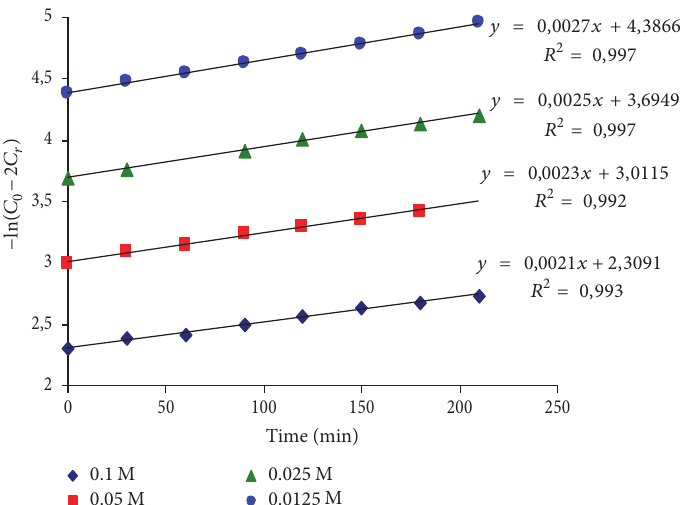
Figure 6: Evolution of the term − ln (𝐶 0 − 2𝐶 𝑟 ) versus time for facilitated extraction of VO 2+ ions by SLM containing extractive agent RESO. [H 3 O + ] = 1M, [RESO] = 10 −2 M, and T = 293 K.